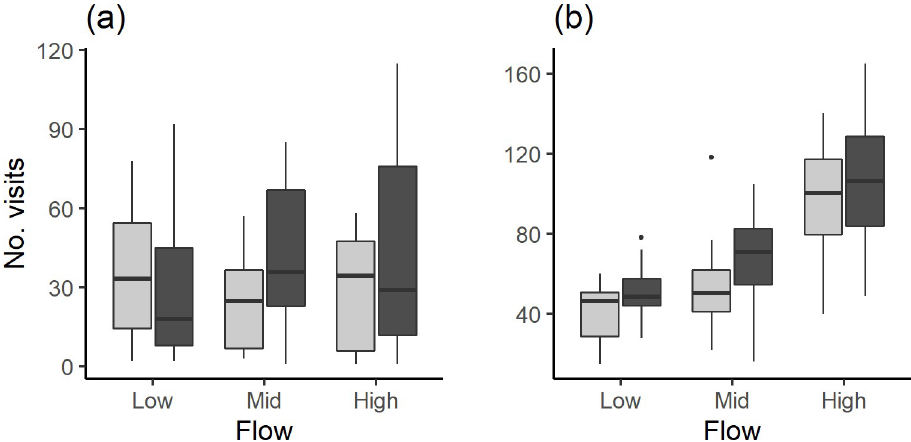
Fig 3. The Number of visits to the central zone for the control (light grey) and visual cue treatment (dark grey) at the three flow velocities for (a) common minnow and (b) brown trout. Note the difference in y-axis scale.